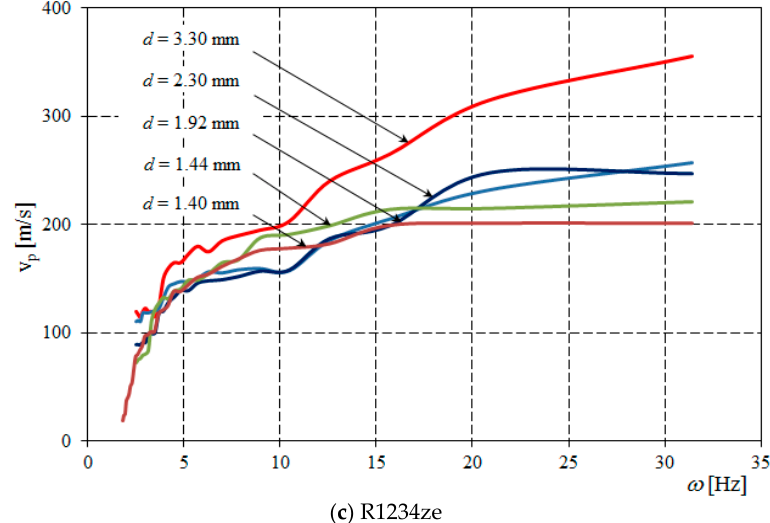
Figure 6. Propagation velocity of pressure instabilities v p m/s as a function of frequency ω of generated disturbances for R134a, R1234yf, and R1234ze refrigerants [17].